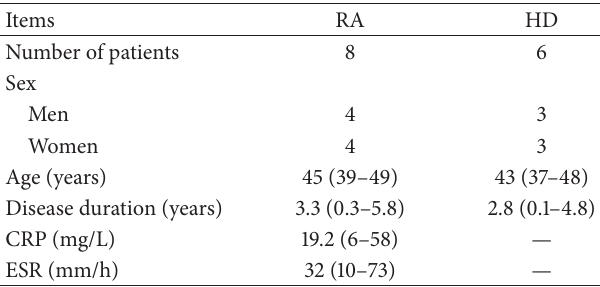
Table 1: Demographics and characteristics of rheumatoid arthritis (RA) patients and healthy donors